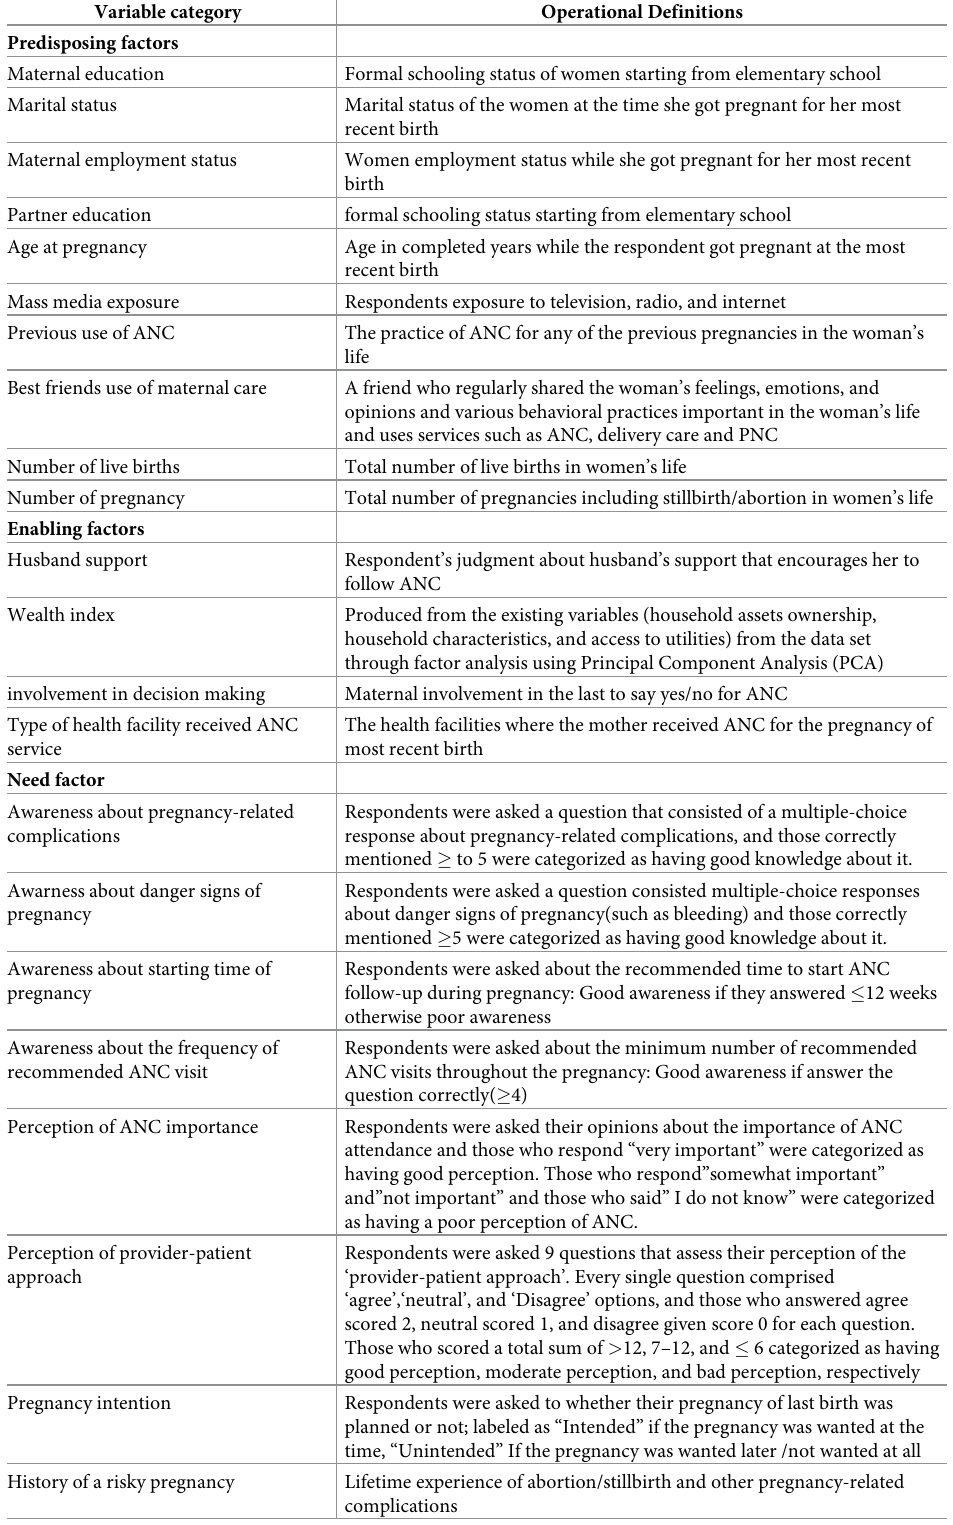
Table 1. Determinant variables for adequate antenatal care service and their operational